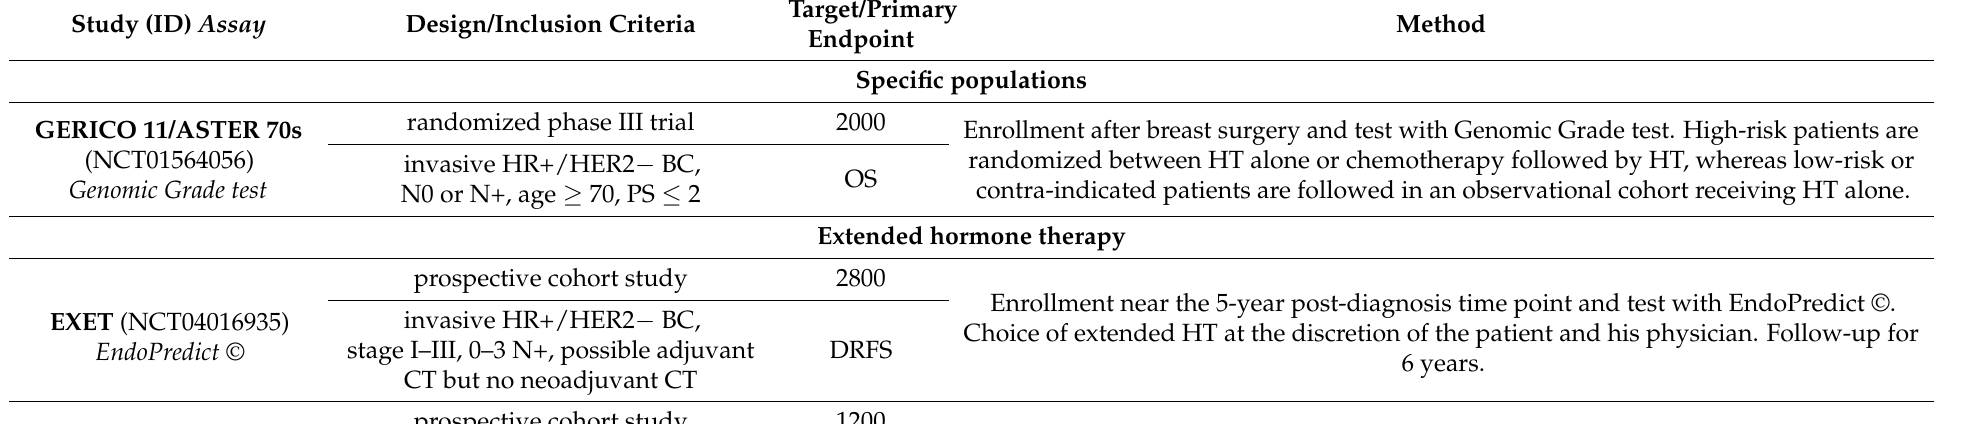
Table 3. Main characteristics of ongoing clinical